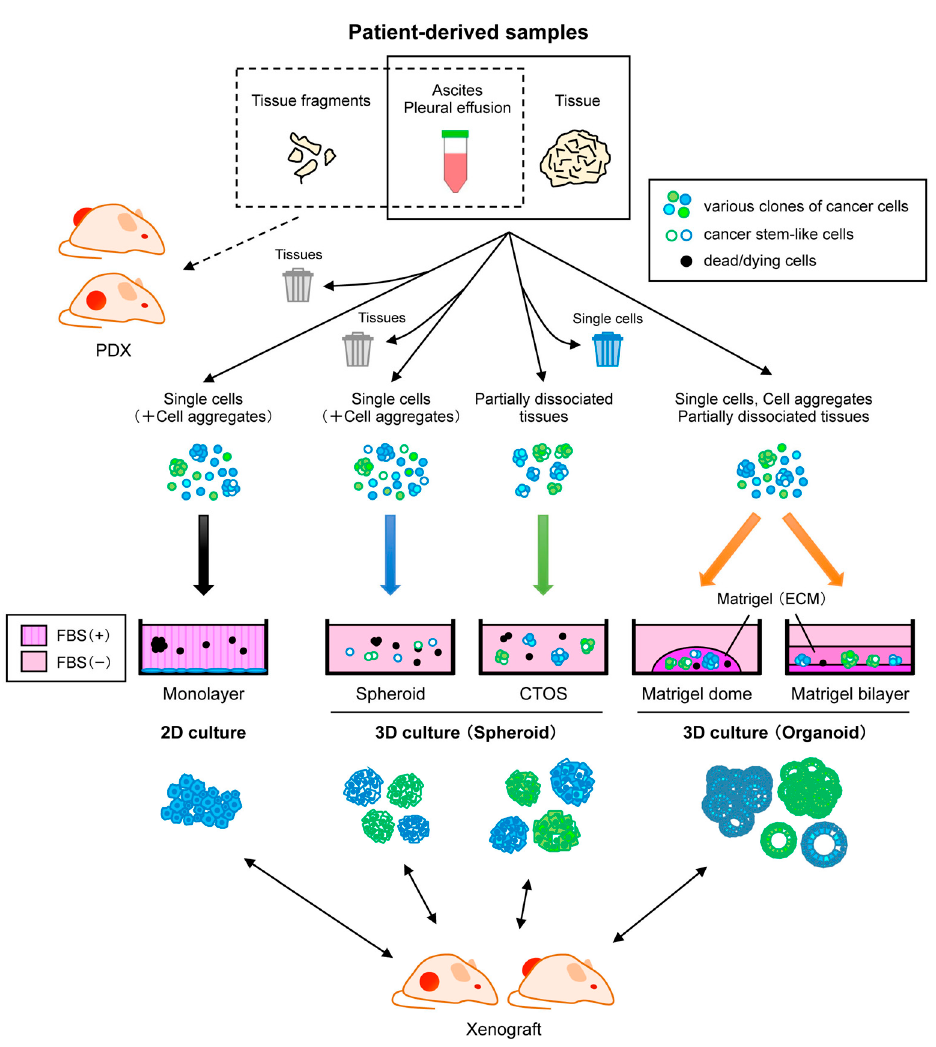
Figure 1. Representative approaches for establishing patient-derived cancer models from diverse clinical samples. Patient-derived xenografts (PDXs) are generated by direct engraftment of clinical samples into immunodeficient mice. Monolayer culture is a common culture method, but cells from primary tumors often undergo crisis, leading to positive selection of specific clones. Spheroid culture with serum-free media is suitable for enrichment of cancer stem-like cells. Cancer tissue-originated spheroids (CTOS) method initiates culture by maintaining cell-cell contact of cancer cells. In the presence of extracellular matrix (ECM) such as Matrigel, organoid culture can propagate both normal and cancer cells while retaining heterogeneity and differentiation. CTOS of ovarian cancer have been not documented yet. These cells cultured by various methods can be used to generate xenografts.